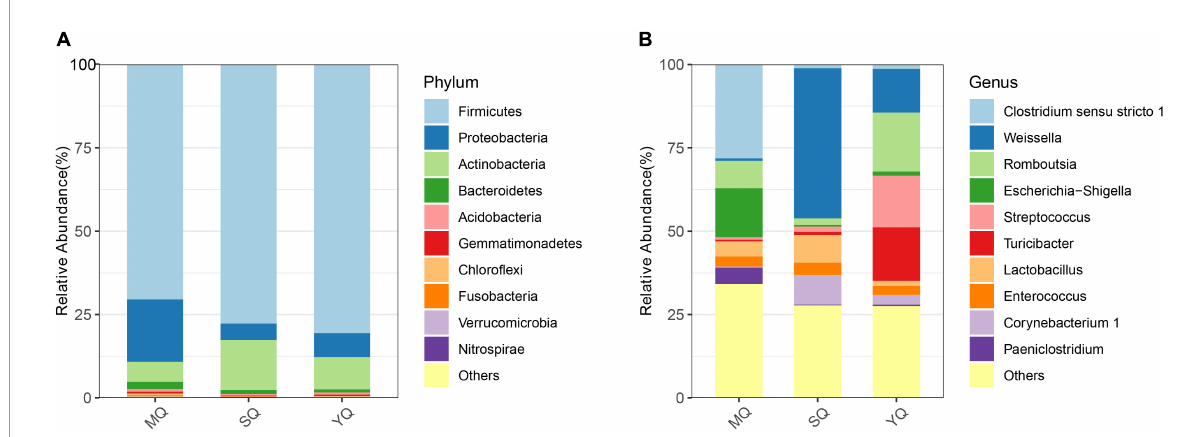
FIGURE2 Bar chart of relative abundance. The relative abundance (%) of the top 10 abundant bacteria phyla (A) and genera (B) among the three ecological bird groups. The dominant phyla in three groups of birds consisted of Firmicutes, Proteobacteria, Actinobacteria, and Bacteroidetes. Others, bacteria taxa with ≤ 1% abundance. MQ, raptors; SQ, waders; YQ,